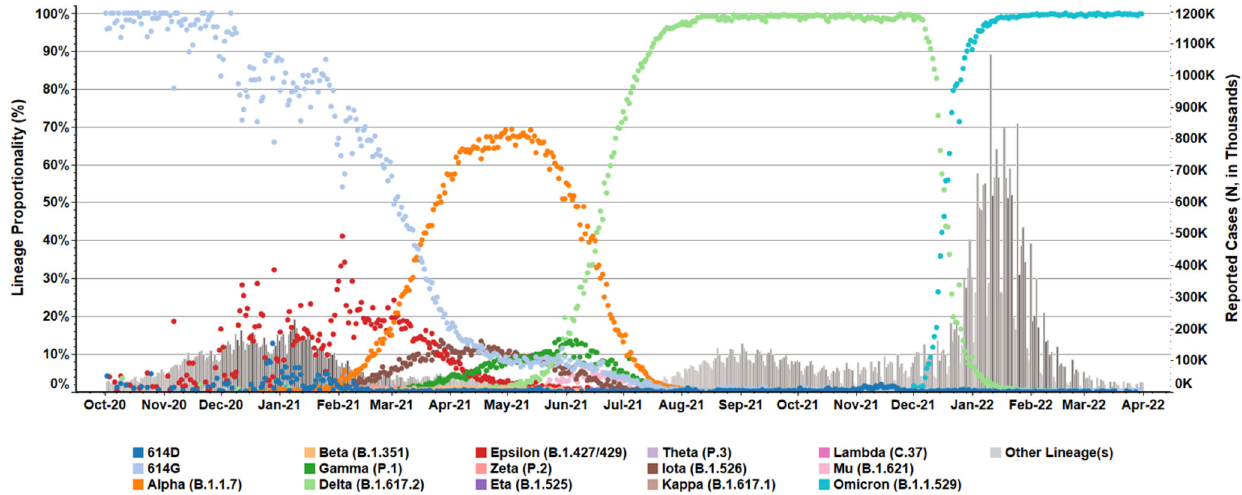
Fig. 1 Prevalence of SARS-CoV-2 variants in the United States. SARS-CoV-2 variant prevalence is highlighted for US clinical specimens processed within the National SARS-CoV-2 Strain Surveillance network, the CDC-contracted diagnostic and research laboratories, and the US baseline surveillance program. Daily incidence (dot icons, 0 to 100%) from October 2020 to March 2022 were indicated for key WHO labeled variants (Pangolin lineage in parentheses), and specimens encoding critical sequence markers (614D/G) but do not belong to those variants. Daily, reported clinical cases are summarized in the bar graph (right-side, dual Y